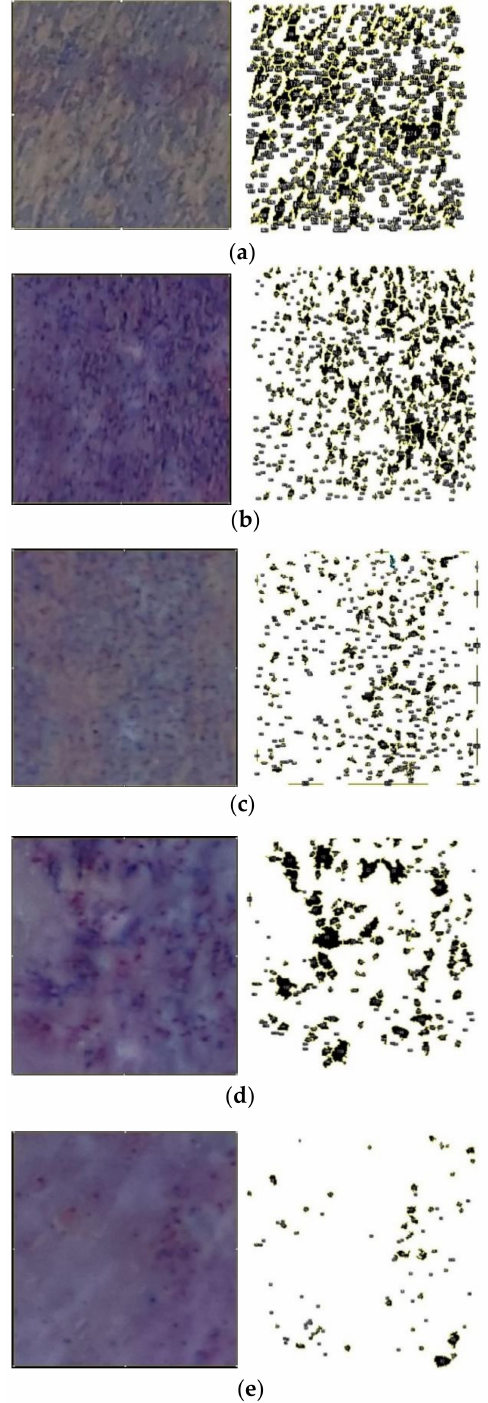
Figure 10. Results of the bacterial test on the fabricated membrane at different SNF concentrations: ( a ) 0 wt.%, ( b ) 0.1 wt.%, ( c ) 0.2 wt.%, ( d ) 0.3 wt.% and ( e ) 0.4 wt.%. Based on these observations, the number of bacterial colonies on the PSF membrane at 0.0 wt.% SNFs was higher compared to the membranes blended with SNFs. Figure 10b–e verifies that the number of bacterial colonies decreased with the increase in SNF concentra- tion. Quantitative observation indicated that the numbers of bacterial colonies appearing on the membrane surface were 497, 448, 377, 169 and 82 for membranes at SNF concentra- tions of 0, 0.1, 0.2, 0.3 and 0.4 wt.%, respectively. This result is in agreement with